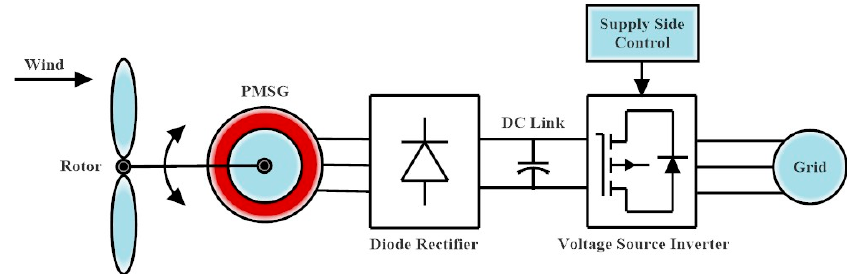
Figure 15. Hard Switching Supply Side Inverter with Voltage Source Inverter (VSI).